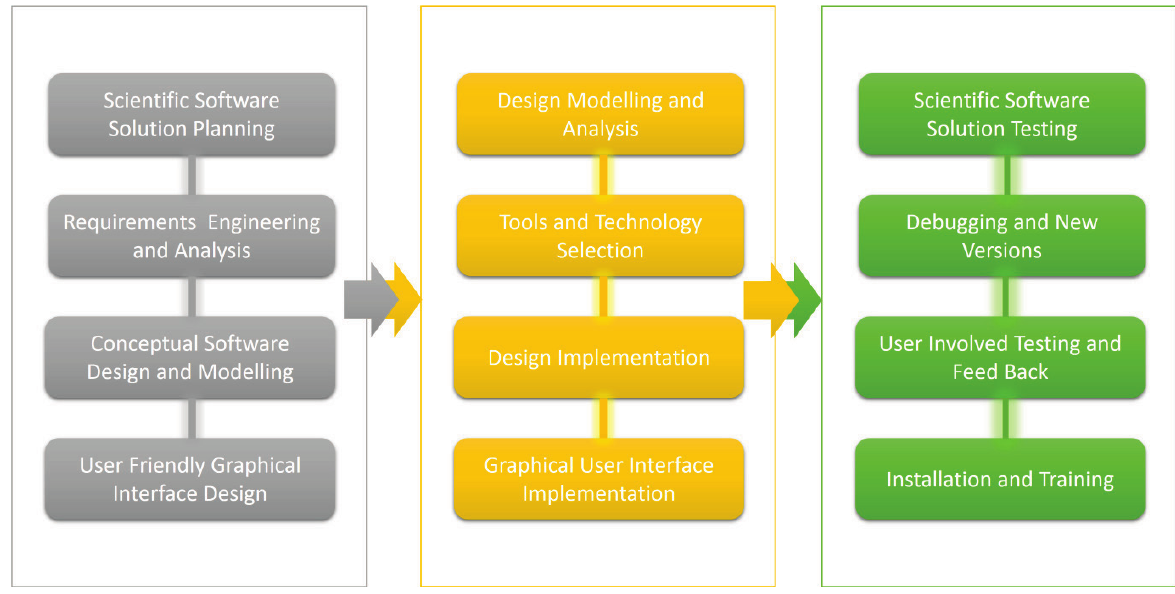
Figure 4. Butterfly three layer model. Shown in gray is the abstract layer, in yellow is the basis for design and development, and in green the implementation and testing by the user. The software is released including installation and